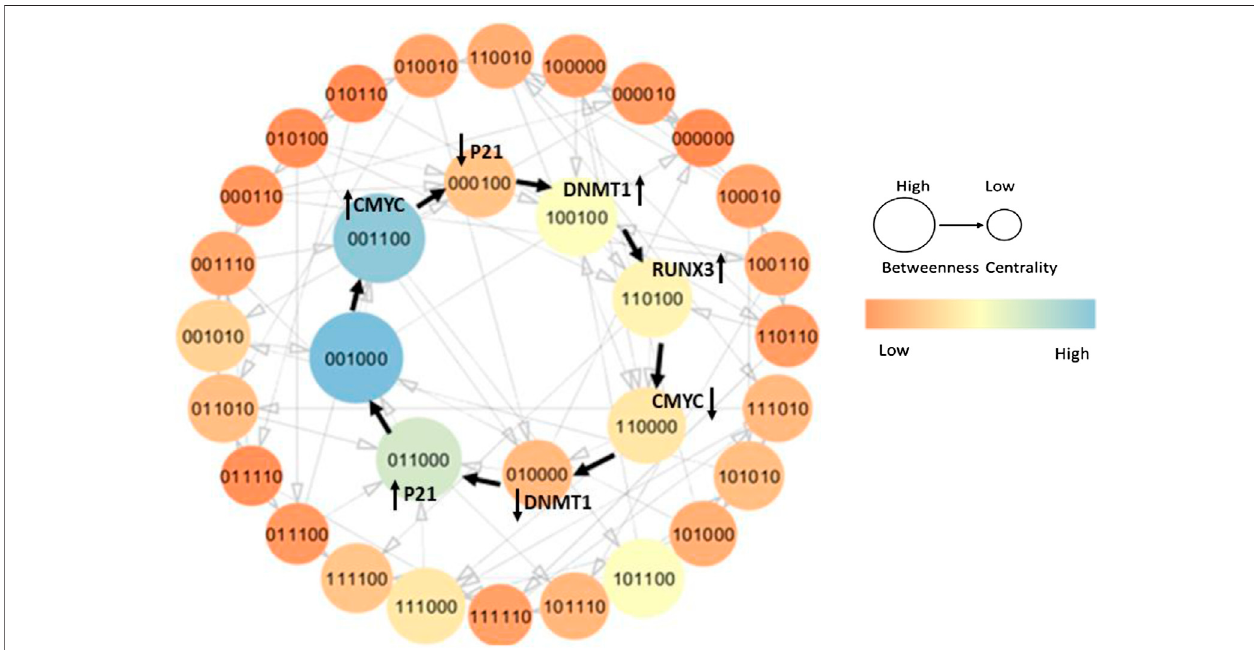
FIGURE 5 | State graph of the recovery cycle from Model 6 (M6) is highlighted with black pointed arrows. Each circle indicates a unique qualitative state with gene entities in the following order: DNMT1, RUNX3 , p21, c-myc, p53, and MDM2, sorted based on betweenness centrality. The recovery trajectory illustrates how a pathogenic system undergoes successivegenetic evolution to reach normal homeostasis. The onset of oncogene c-myc introducespathogenesis and tends toretain it bydownregulatingp21andupregulatingDNMT1.However,theactivationofTSG RUNX3 limitstheoverexpressionofDNMT1byinhibitingc-mycandrestoringthe p21 expression. The normal state characterized as (0,0,1,0,0,0) exhibits a high betweenness centrality as shown with a larger diameter and lighter color in the state graph. The color bar on the right side signi fi es the trend of betweenness centrality; that is, the lighter is the color and the larger is the diameter, the higher is the betweenness centrality of the qualitative state and vice